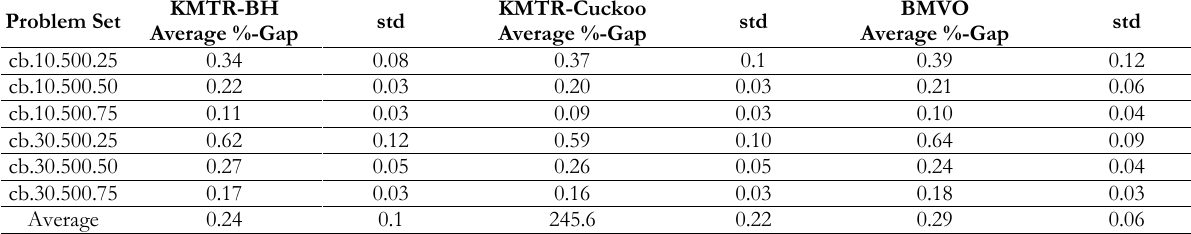
Table 4. Summary of OR-Library benchmarks MKP CB.10.500 and